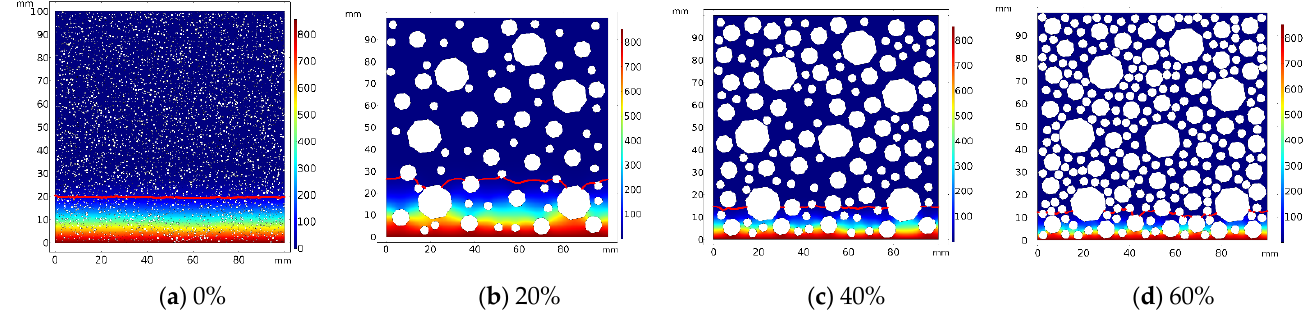
Figure 6. Simulation results of chloride ion diffusion under different volume fractions of the aggregate under a hydrostatic pressure of 0.5 MPa.